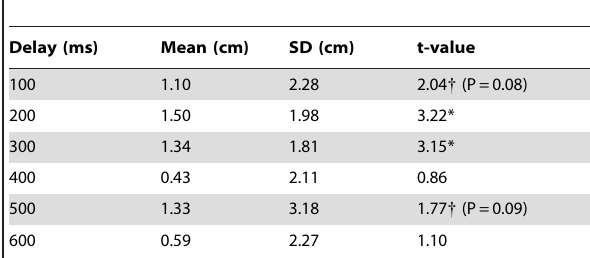
Table 1. Proprioceptive drift in each delay